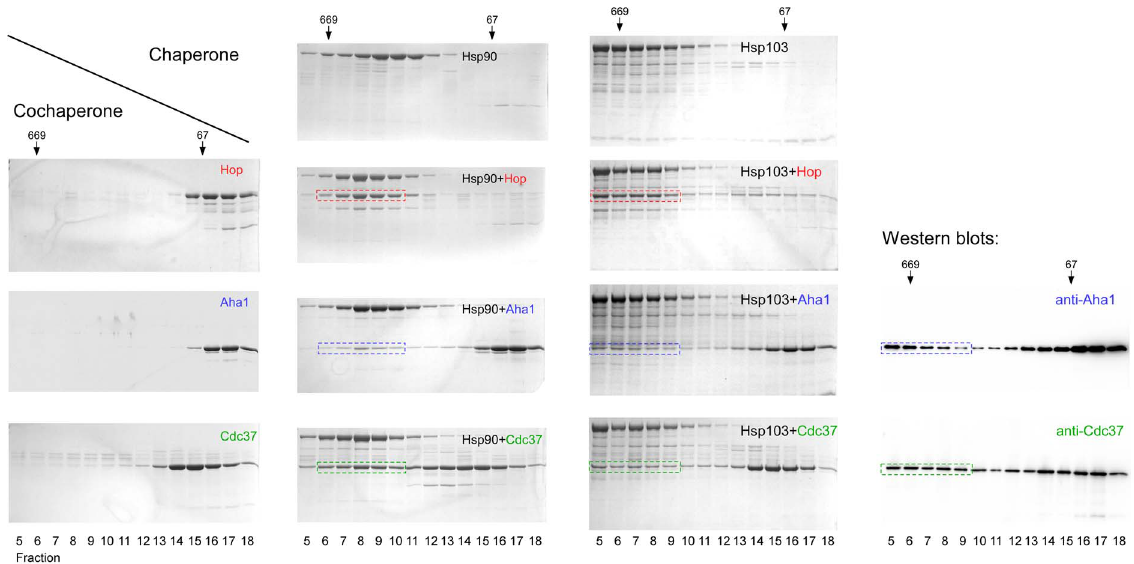
Figure 3. Interaction of Hsp103 with cochaperone proteins. Purified Hsp90 a , Hsp103, Hop, Aha 1 and Cdc37 were mixed as indicated and fractionated by gel filtration chromatography on a Superdex 200 column. Fractions were analyzed by SDS-PAGE. Marker proteins are shown on top (thyroglobulin, 669 kDa; BSA, 67 kDa). The shift of the cochaperones Hop, Aha1 and Cdc37 indicating complex formation with Hsp90 a and Hsp103 is marked by red, blue or green dashed lines, respectively. For the Hsp103 + Aha1 and Hsp103 + Cdc37 interaction runs the cochaperones were blotted with specific antibodies to prove the identity of the shifted Aha1 and Cdc37 bands that indicate complex formation with Hsp103.